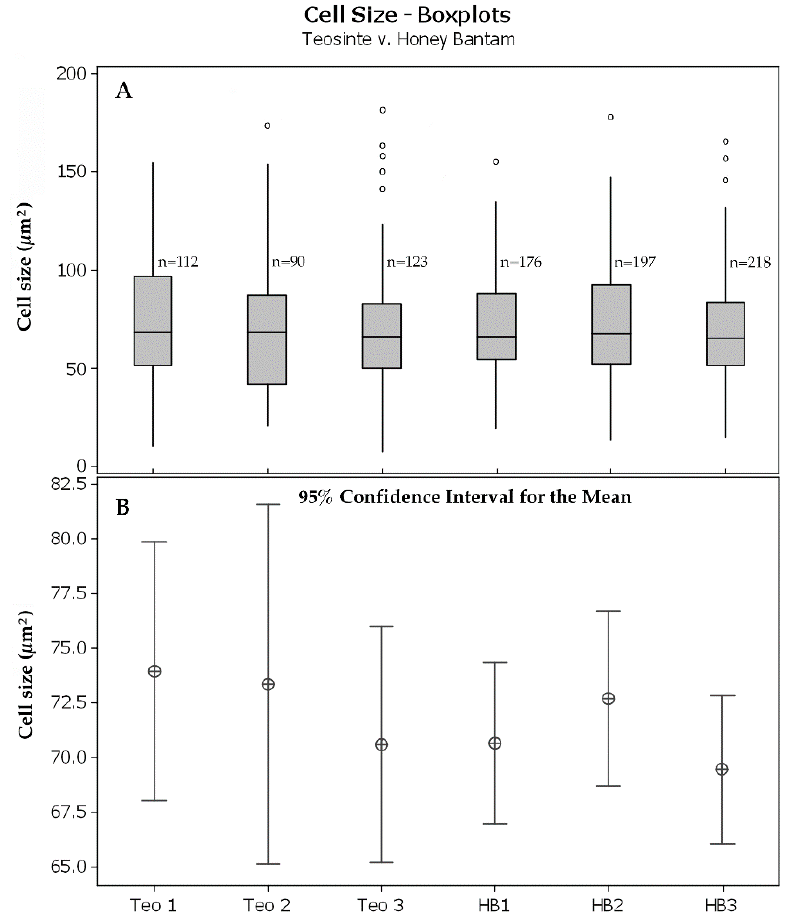
Figure 5. Analysis of transverse cytoplasmic areas of parenchymatous cells inside of the pericycle ca. 100 µ m from the RCJ in teosinte and sweetcorn maize. ( A ) Boxplots of computed transverse cytoplasmic areas of teosinte and ‘Honey Bantam’ ( n = 3 each). ( B ) 95% confidence intervals for mean parenchymatous cell areas from the same roots described in “A”. Mean cell areas were not significantly different (one-way ANOVA: F = 0.58, df = 5/890, P = 0.717).